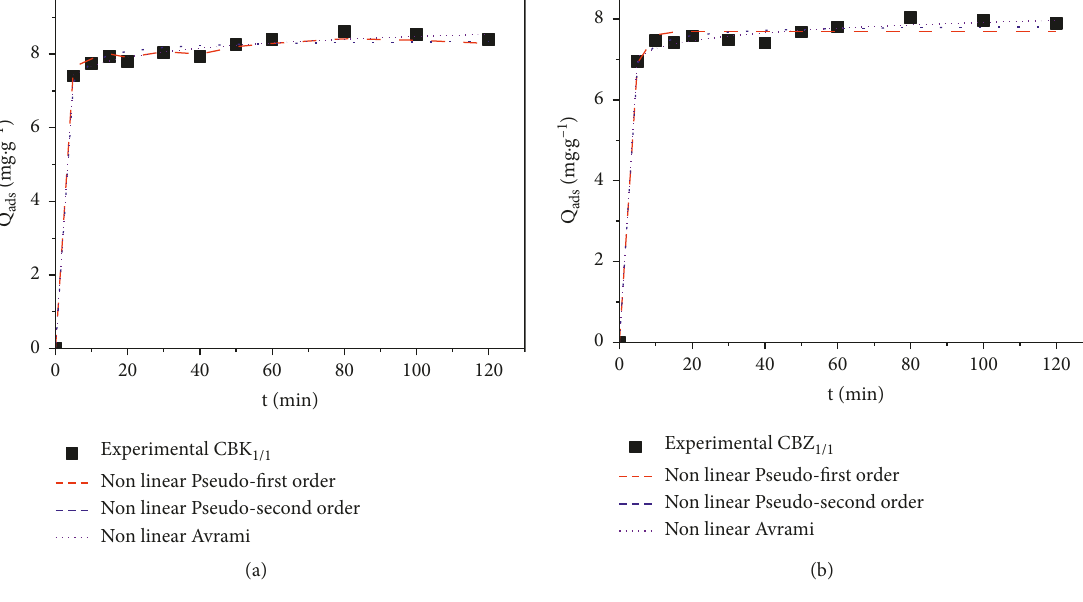
Figure 13: Nonlinear regression of adsorption